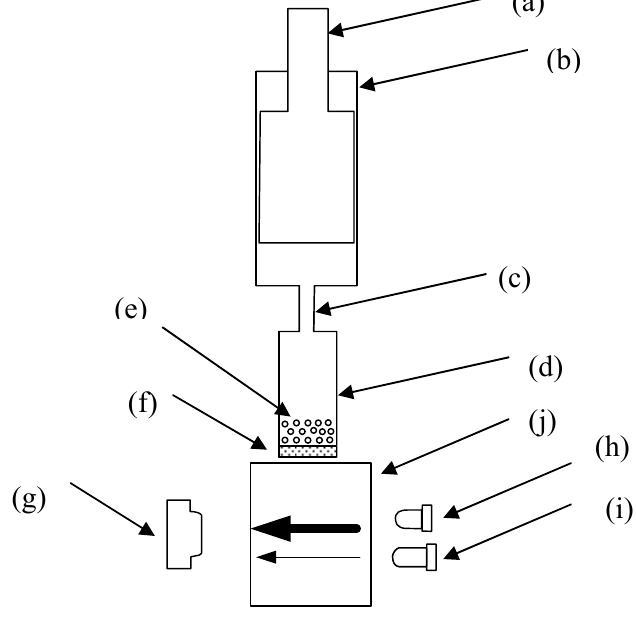
Figure 2. Schematic diagram of the proposed optical biosensor: ( a ) plunger; ( b ) upper chamber; ( c ) middle chamber; ( d ) bottom chamber; ( e ) Ni-NTA; ( f ) filtrating membrane; ( g ) PIN-FET; ( h ) blue LED with wavelength of 400 nm; ( i ) red LED with wavelength of 610 nm; and ( j ) optical